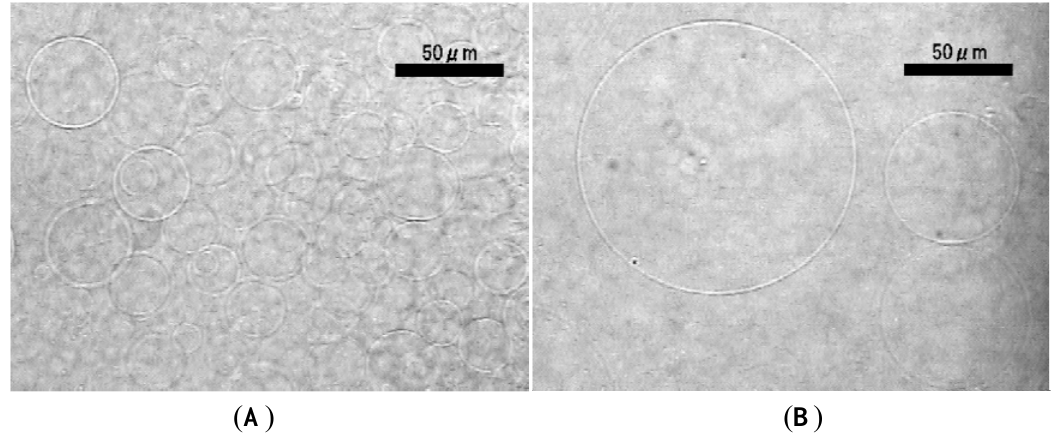
Figure 2. Typical GVs formed from egg phosphatidylcholine deposited on a planar